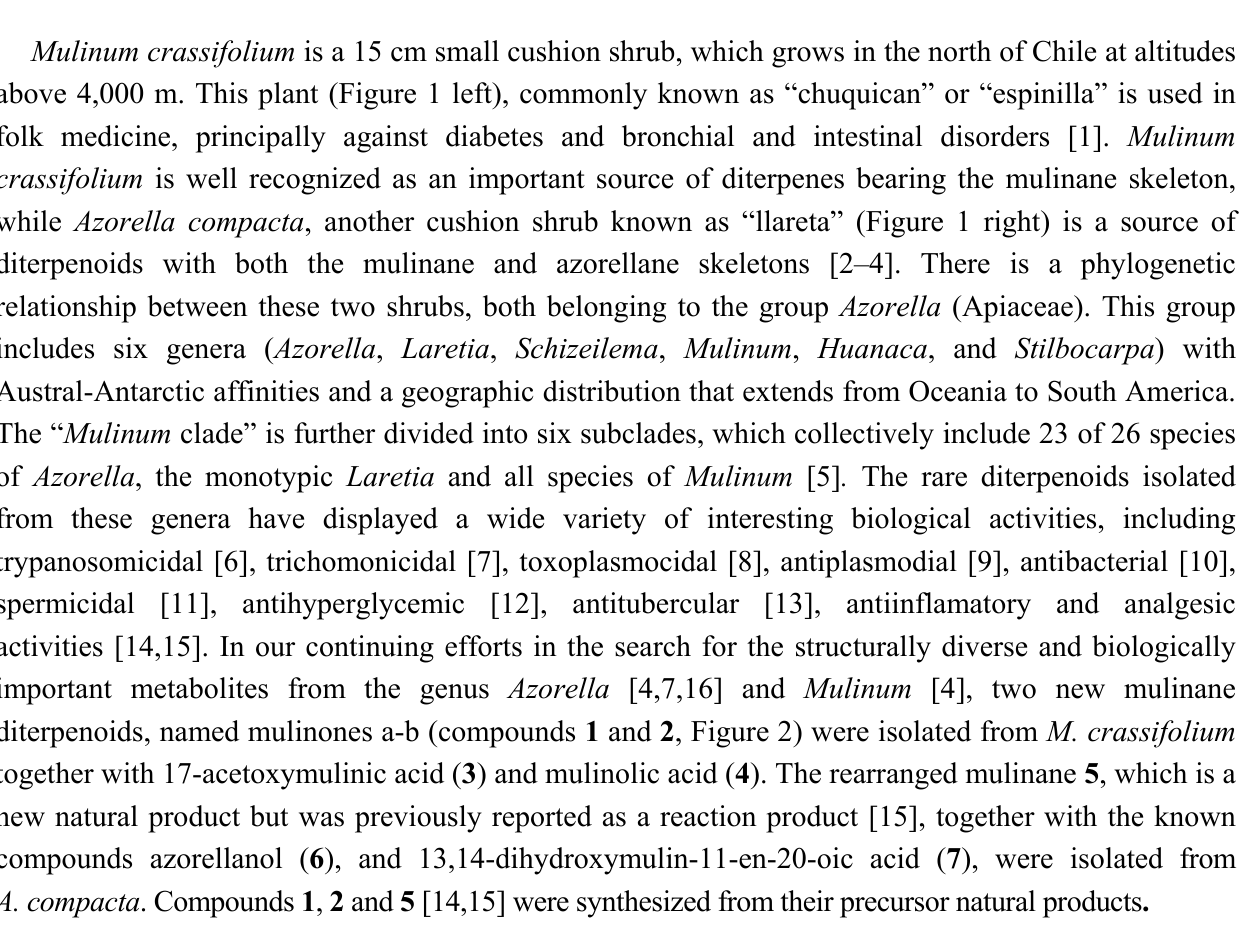
Figure 1. Pictures of Mulinum crassifolium (left) and Azorella compacta (right), from Northern Chile. (Taken by Jorge Bórquez and Mario J. Simirgiotis, on March